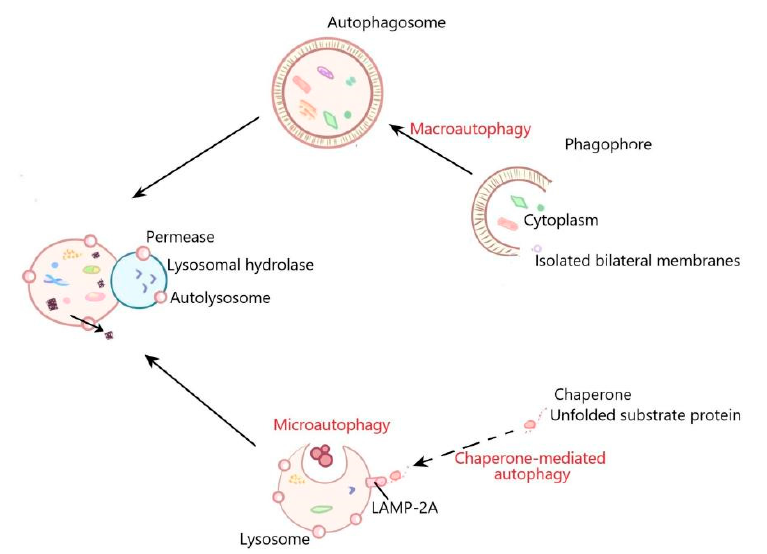
Figure 1. The general process of macroautophagy, microautophagy, and chaperone-mediated au- tophagy. In the process of macroautophagy, the contents are encapsulated by a bilayer membrane structure to form autophagosomes. Autophagosomes then fuse with lysosomes to form autolyso- somes, in which the separated contents are usually degraded for recycling. Microautophagy refers to the direct invagination of lysosomal membrane, which then encapsulates cell contents. In the process of chaperone mediated autophagy, the cytoplasmic proteins are transported to lysosomal chambers after binding with chaperones, and then digested by lysosomal